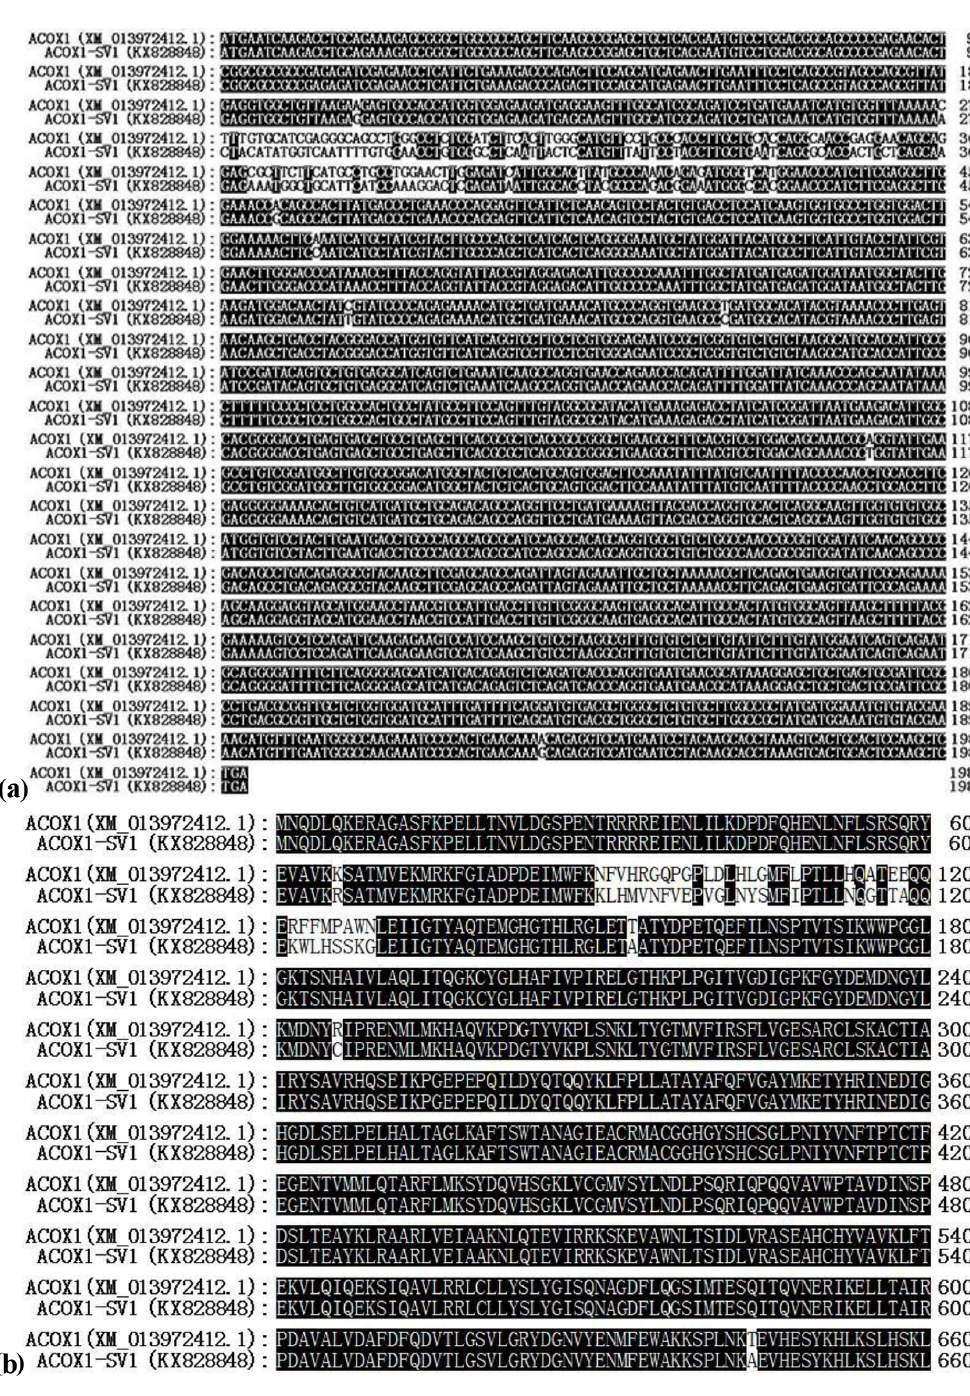
www.arch-anim-breed.net/61/59/2018/ Arch. Anim. Breed., 61, 59–70,